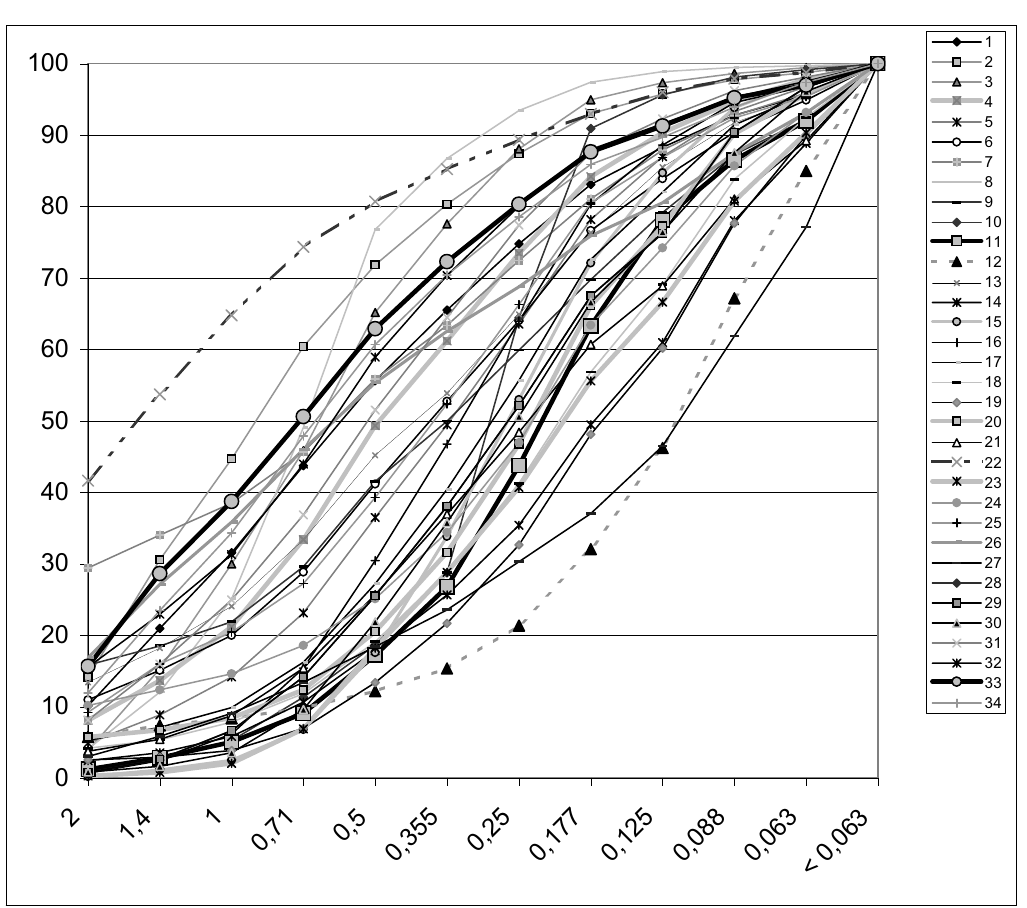
Fig. 2 – Particle size of the urban street sediments around Guanabara